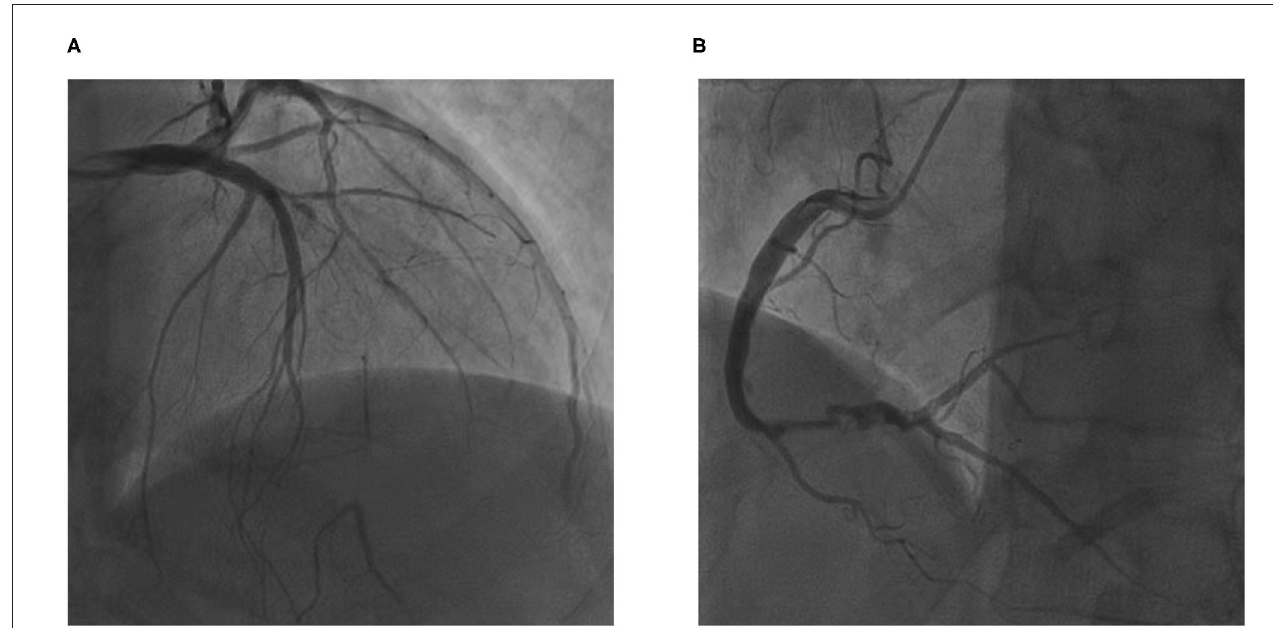
FIGURE 1 | The patient’s coronary angiography. (A) In-stent chronic total occlusion of left anterior descending artery and a proximal septal branch supplying the distal left anterior descending (LAD). (B) Severe in-stent restenosis of right coronary